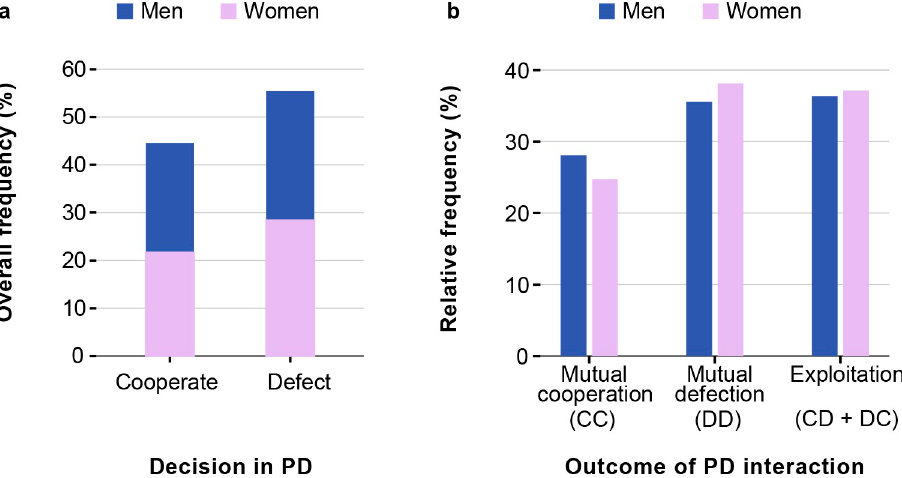
Fig 4. The overall distribution of decisions (a) and the distribution of each interaction outcomes for men and women (b) in the Prisoner’s Dilemma games. Classification of interactions: mutual cooperation (CC): both partners decided to cooperate; mutual defection (DD): both partners decided to defect; exploitation (CD or DC): partners have chosen different options.